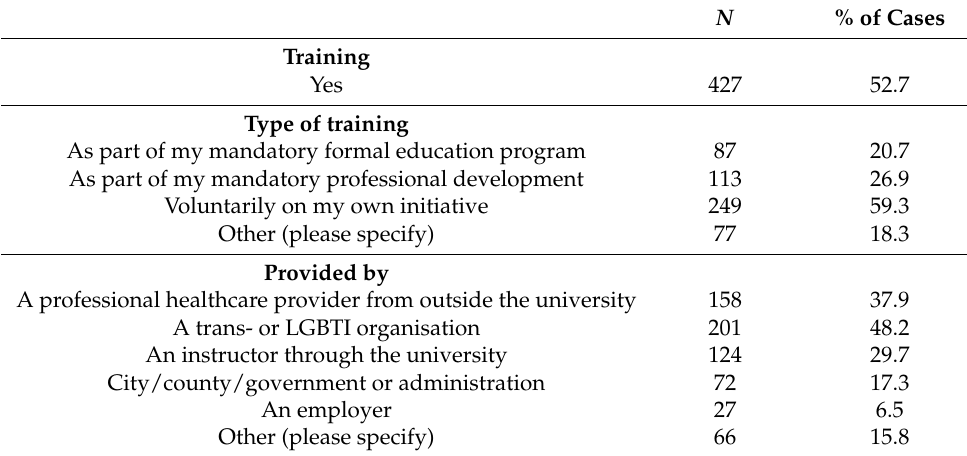
Table 2. Training experiences N